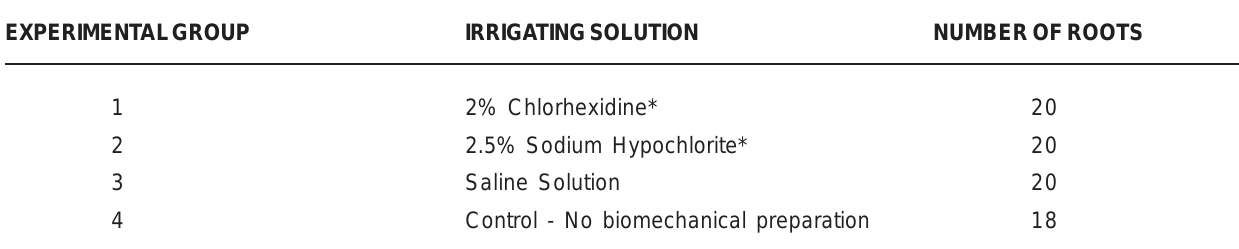
* Chemistry Institute, UNESP